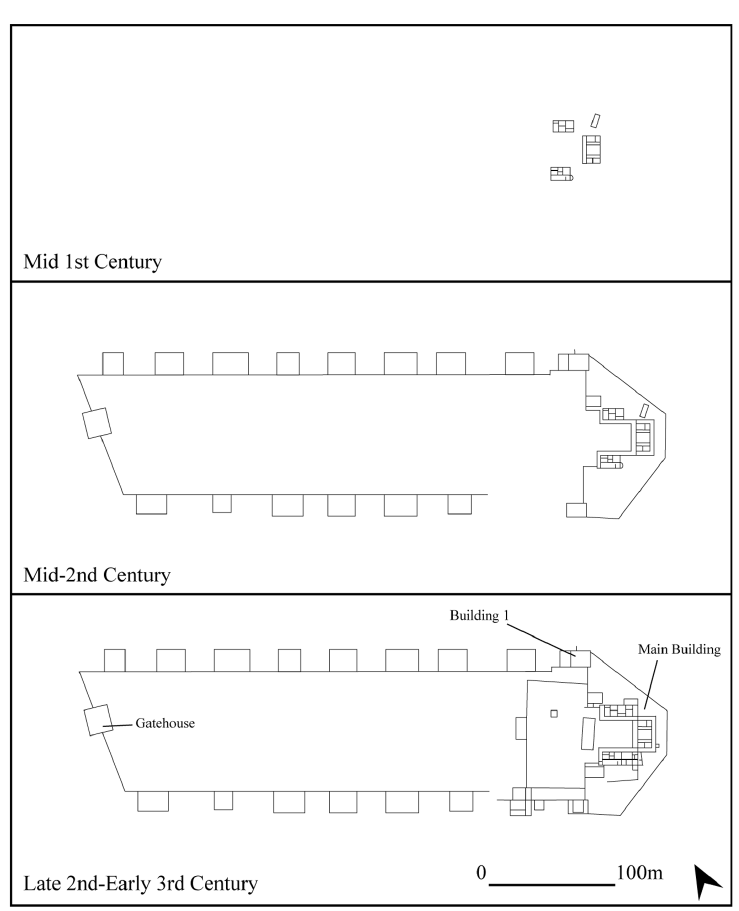
Figure 6: The development of the axially orientated compound at Borg showing building numbers mentioned in the text and the structural sequence until the early third century AD. The sequencing of the pars rustica is somewhat tentative, given that much of the detail is based on geophysical survey (J.